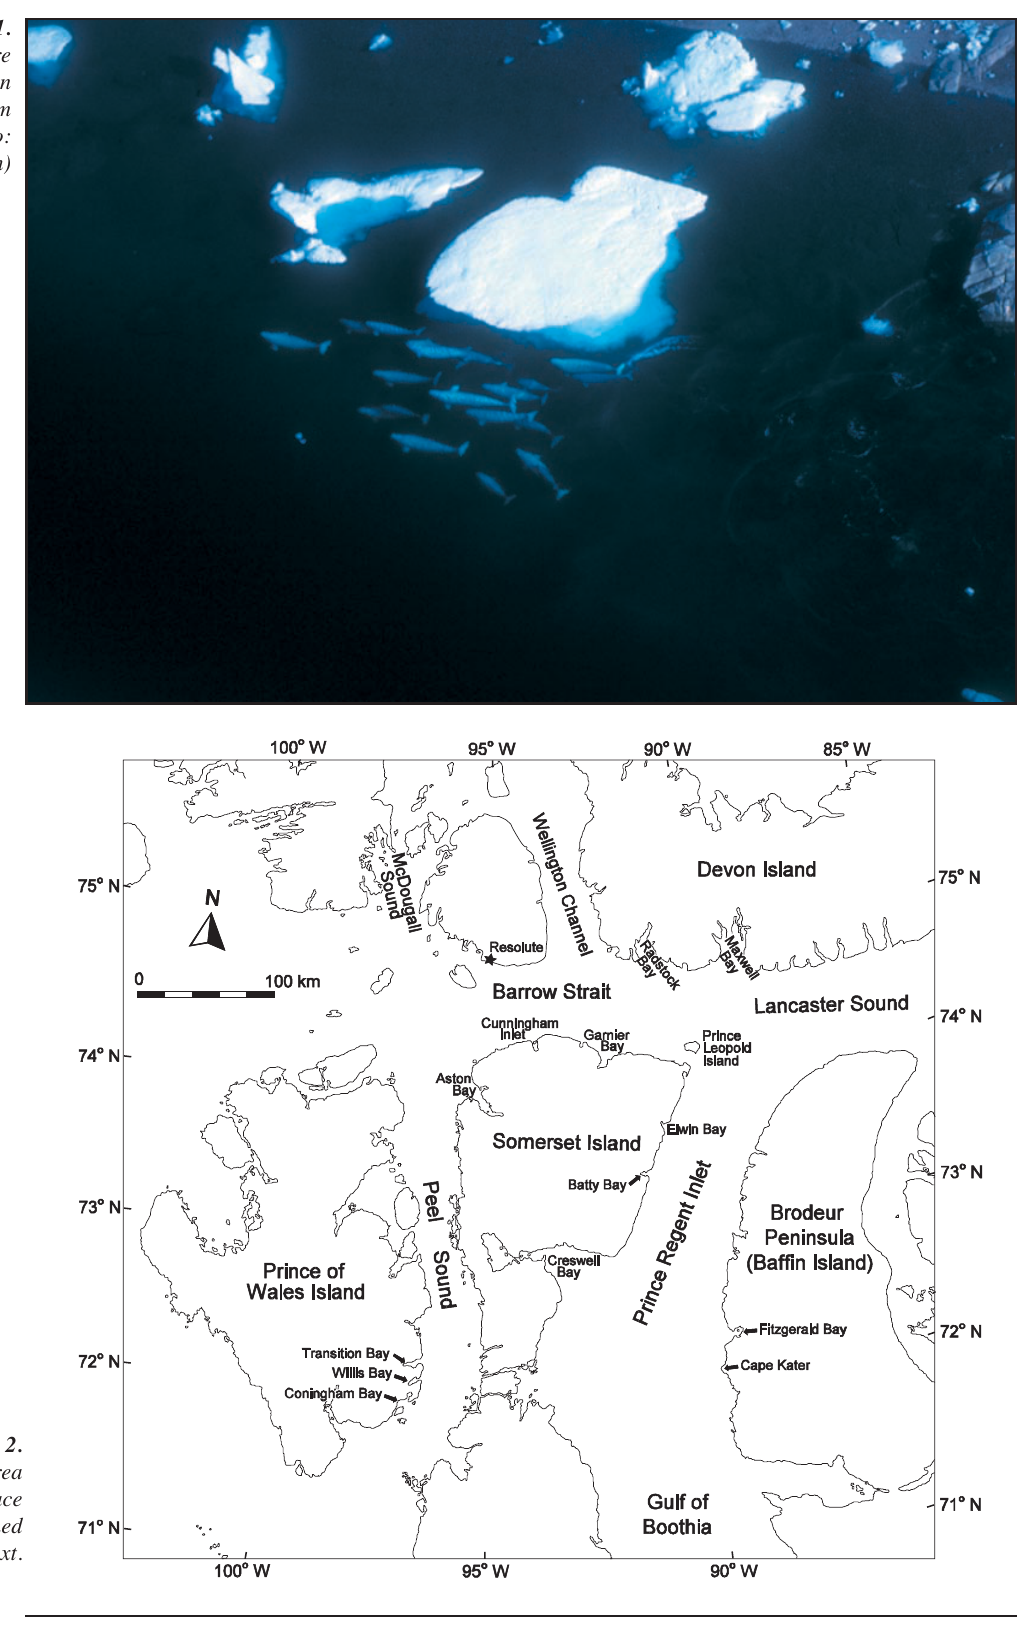
Fig. 1. Adult beluga are easily visible in clear water from the air. (Photo: Vidar Bakken)